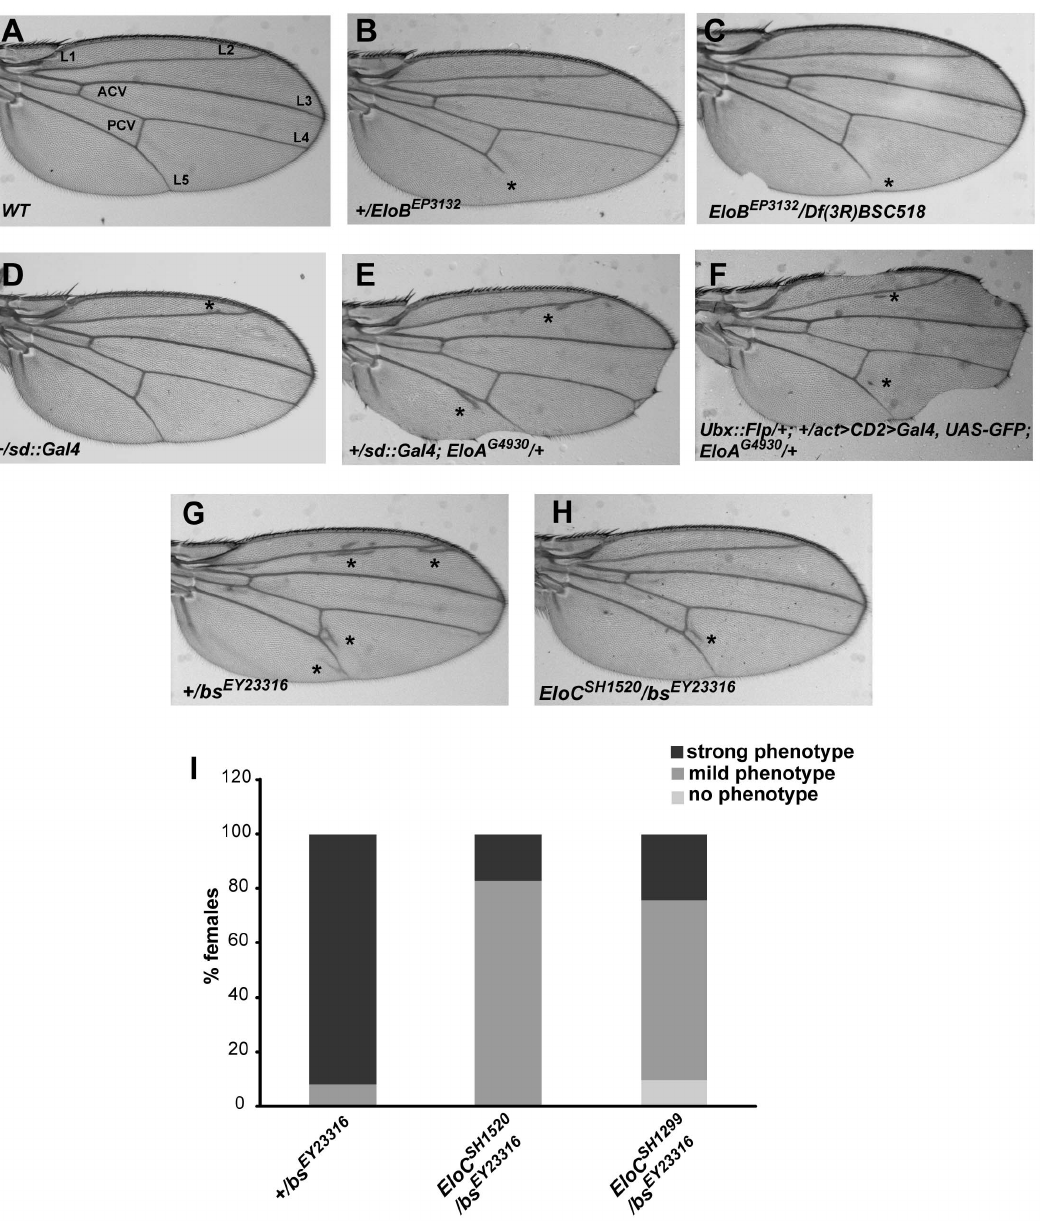
Figure 5. Elo genes control wing cell identity. (A): Wing from control w 1118 fly (L1-L5: longitudinal veins; ACV and PCV: anterior and posterior cross-veins). (B, C): Wings from + /EloB EP3132 and EloB EP3132 /Df(3R)BSC518 flies exhibit truncated L5. (D): Wings from + /sd::Gal4 flies have a very faint ectopic vein phenotype and no margin phenotype. (E, F): Wings from flies over-expressing EloA exhibit ectopic vein and margin phenotypes. (G, H, I): EloC SH1520 and EloC SH1299 loss-of-function alleles diminish expressivity of the ectopic vein phenotype induced by the bs EY23316 loss-of-function allele. Strong phenotype: ectopic veins everywhere in the wing (shown in G). Mild phenotype: ectopic veins under the posterior cross-vein only (shown in H).